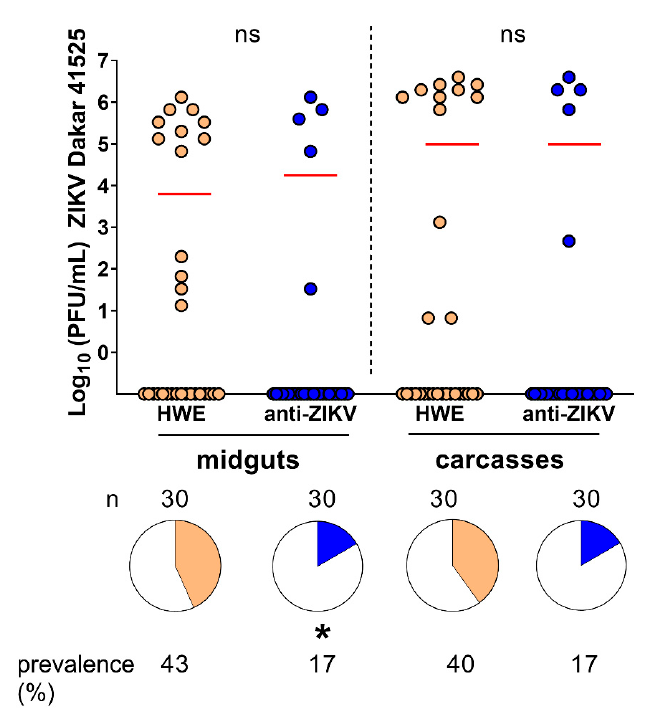
Figure 7. Anti-ZIKV-NS3 / 4A mosquitoes are significantly resistant to ZIKV Dakar 41525 in their midguts. Infected midguts ( left ) or carcasses ( right ) of anti-ZIKV-NS3 / 4A (“anti-ZIKV”) and HWE mosquitoes at 14 dpi after infection with ZIKV Dakar. Red bars indicate median virus titers. “ns” above graph refers to virus titers between infected groups. Stars below pie charts compare infection prevalence; n = number of mosquitoes tested, ns = not significant; * = p < 0.05.